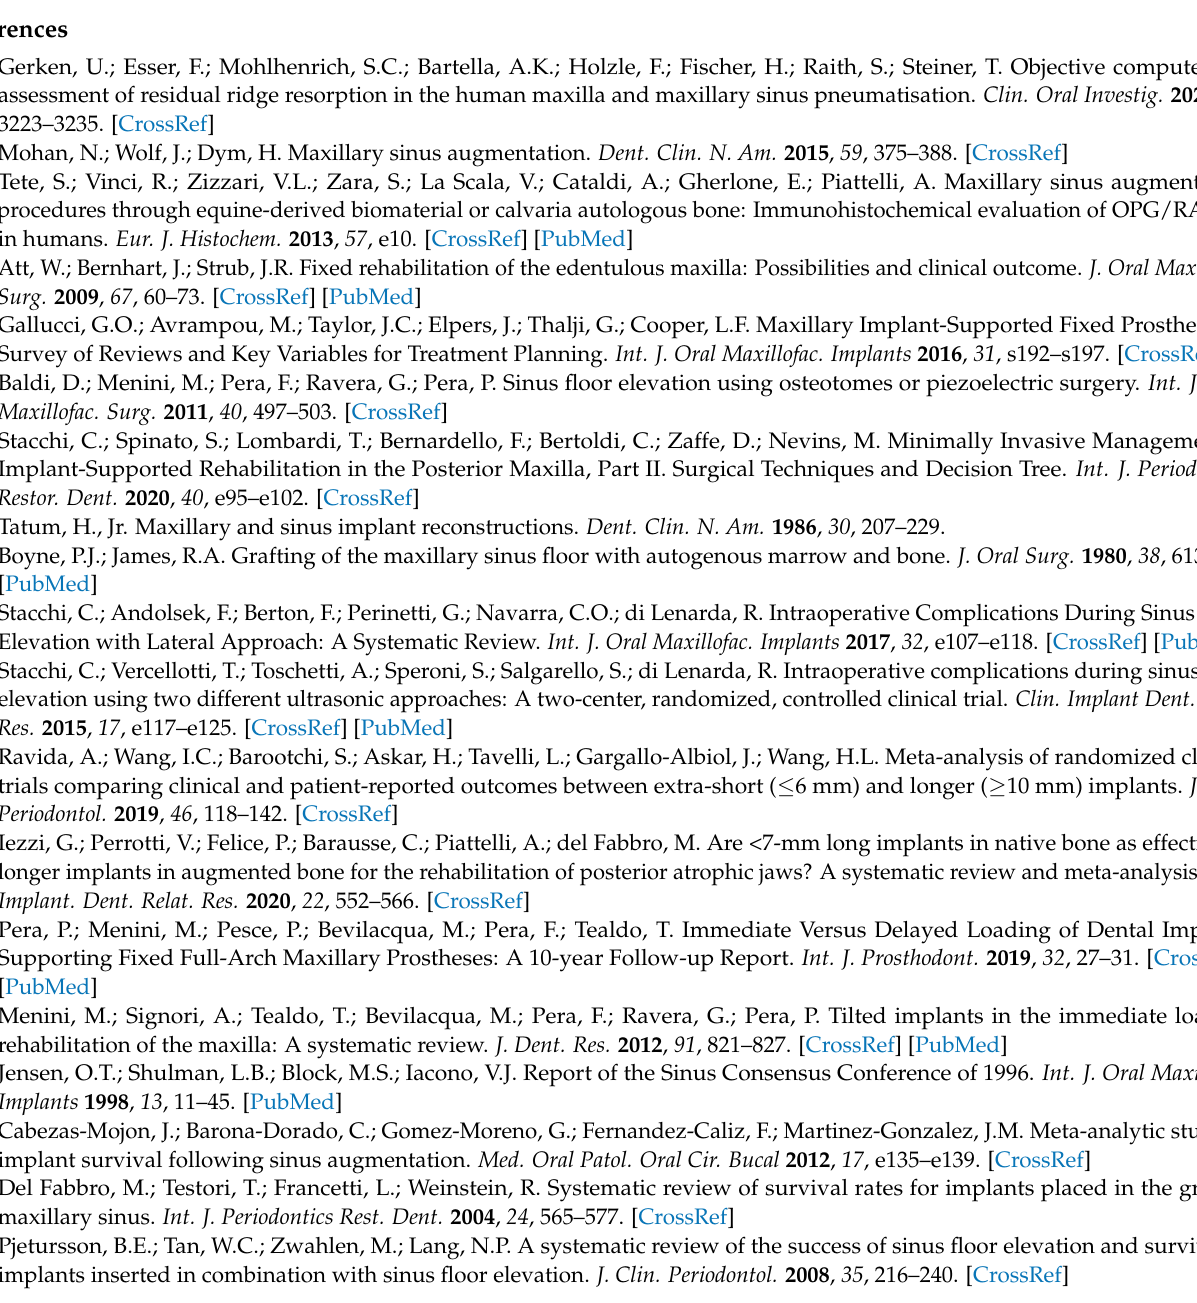
Table S2: Main characteristics of the included studies, Table S3: P-values of the comparisons among groups, Table S4: Main characteristics of the included studies for volumetric changes, Table S5: Main characteristics of the included studies for histomorphometric and linear